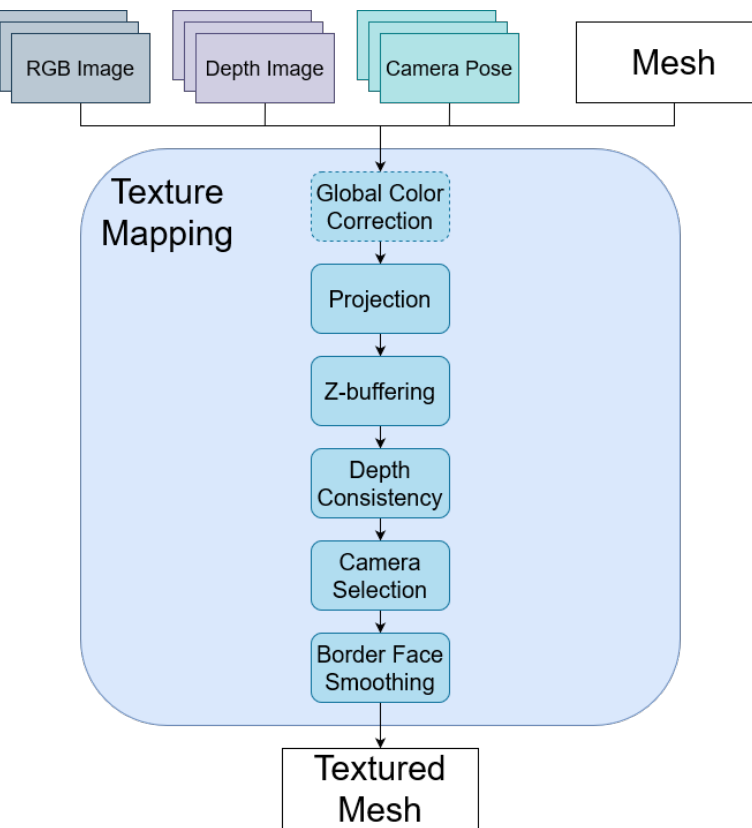
Figure 3. Proposed system